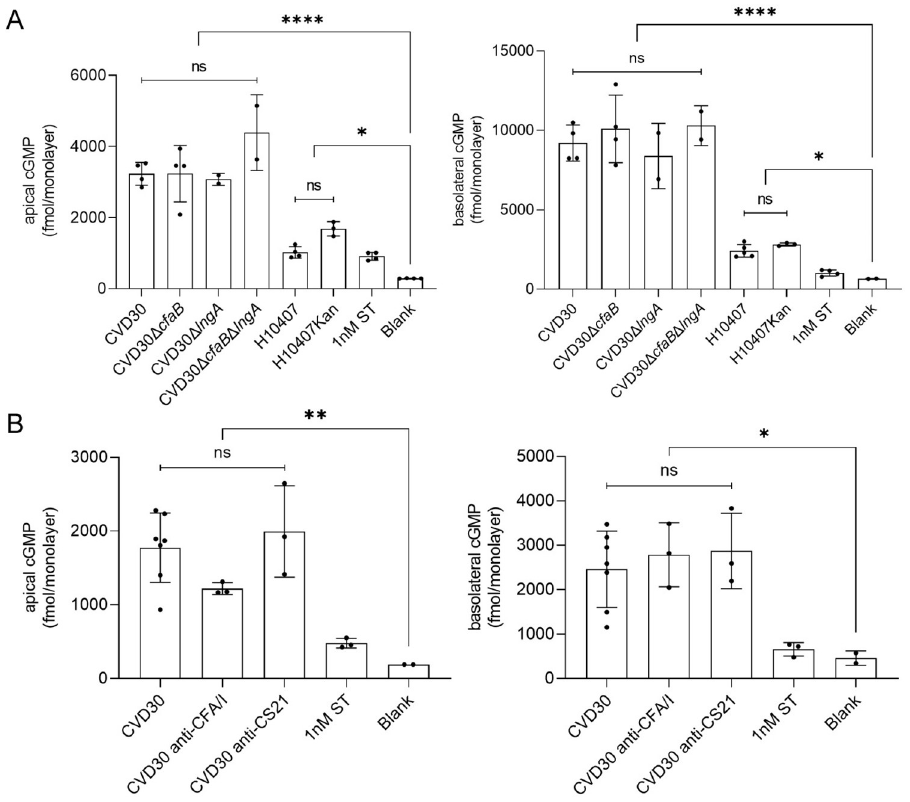
Fig 9. The polarized production of cGMP in human ileal enteroid monolayers following infection by CVD30 and CF-deficient mutant strains. Differentiated ileal enteroid monolayers (35I) were infected with wildtype strain CVD30 or CFA/I- and CS21-deficient strains for 8hrs (A) or infected for 4 hrs with wildtype strain CVD30 with or without pre-incubation with CFA/I- or CS21- antibodies (B). Apical and basolateral supernatants were collected for cGMP ELISA. Data presented are pooled from two independent experiments (A) or four independent experiments (B). Each dot represents data collected from an individual monolayer. Toxin delivery results were confirmed in one jejunal enteroid line. Error bars indicate standard deviations from the means. The asterisks above the bars indicate statistically significant differences determined using one-way ANOVA with Bonferroni’s multiple-comparison test. � , p < 0.05; �� , p < 0.01; ���� , p <